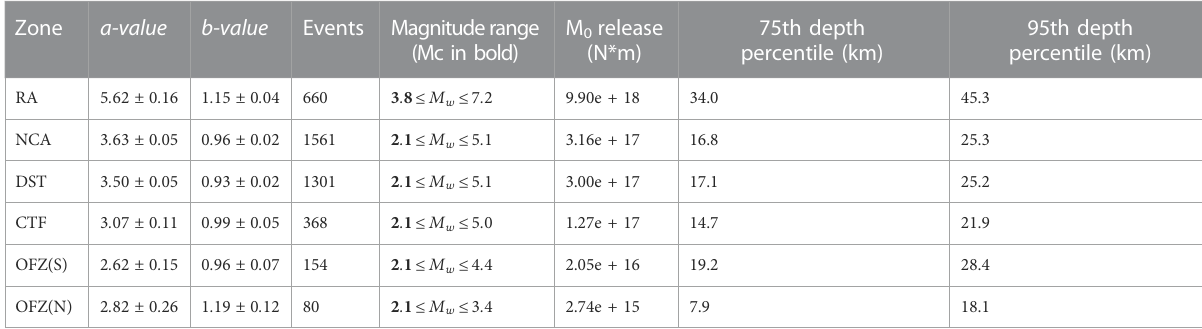
TABLE 3 Seismic characteristics of tectonic zones (Figures 4,